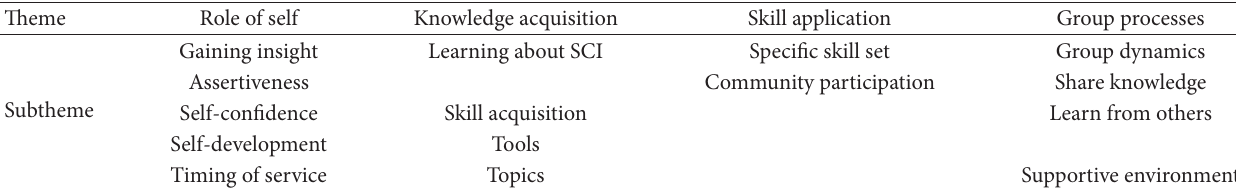
Table 4: Themes and subthemes related to CROP service